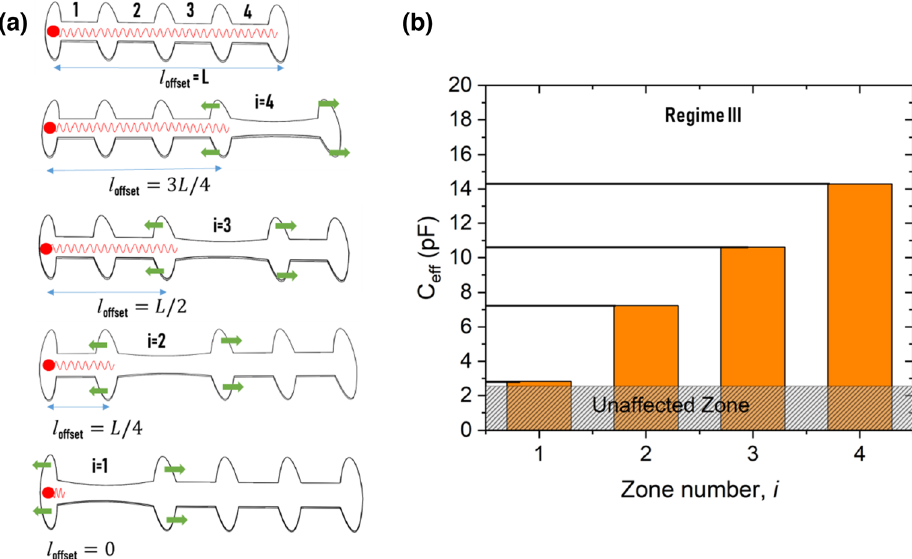
Figure 6. Regime III: ( a ) Schematic of signal behavior in regime III: the voltage dissipates at the beginning of the stretched zone and always dwells before the stretched zone. l offset locates the beginning of the stretched domain; ( b ) effective capacitances at ε = 12% and f = 500 kHz when stretching different zones of the transmission line (the effective capacitance increases linearly with zone number